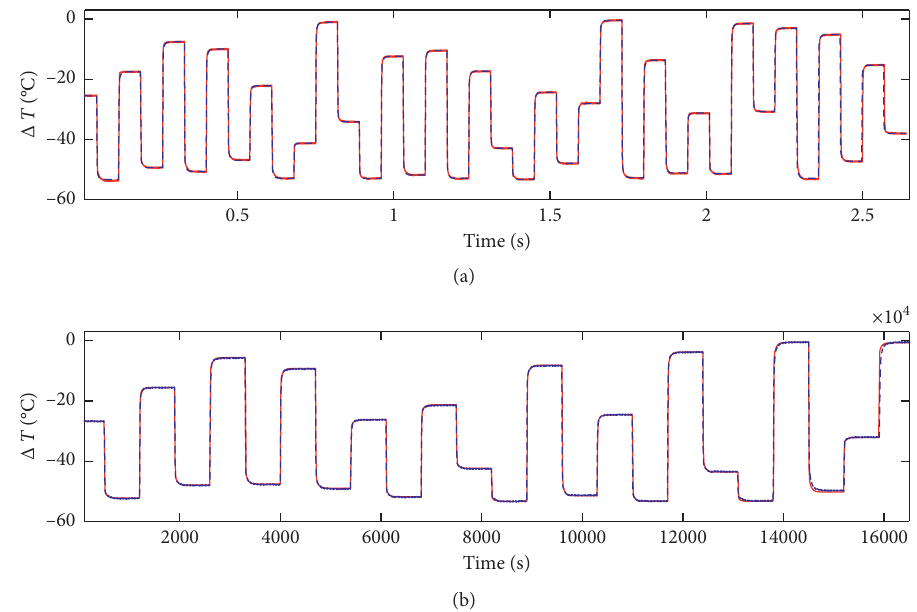
Figure 24: Comparison between thermal process output (red) and estimated model output (blue dashed line). (a) Comparison on es- timation dataset. (b) Comparison on validation